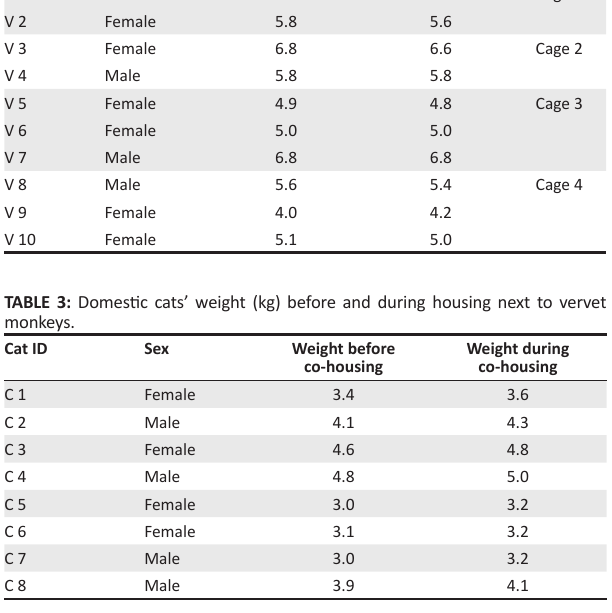
TABLE 2: Vervet monkeys’ weight (kg) before and during housing next to domestic cats. Vervet ID Sex Weight before